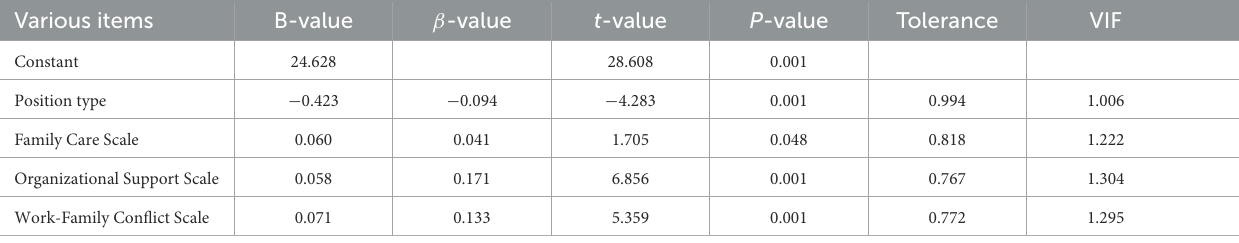
TABLE 5 Multiple stepwise regression results of nurses’ family caring, perception of organizational support, and work-family conflict on compassion satisfaction ( n = 2,014). Various items